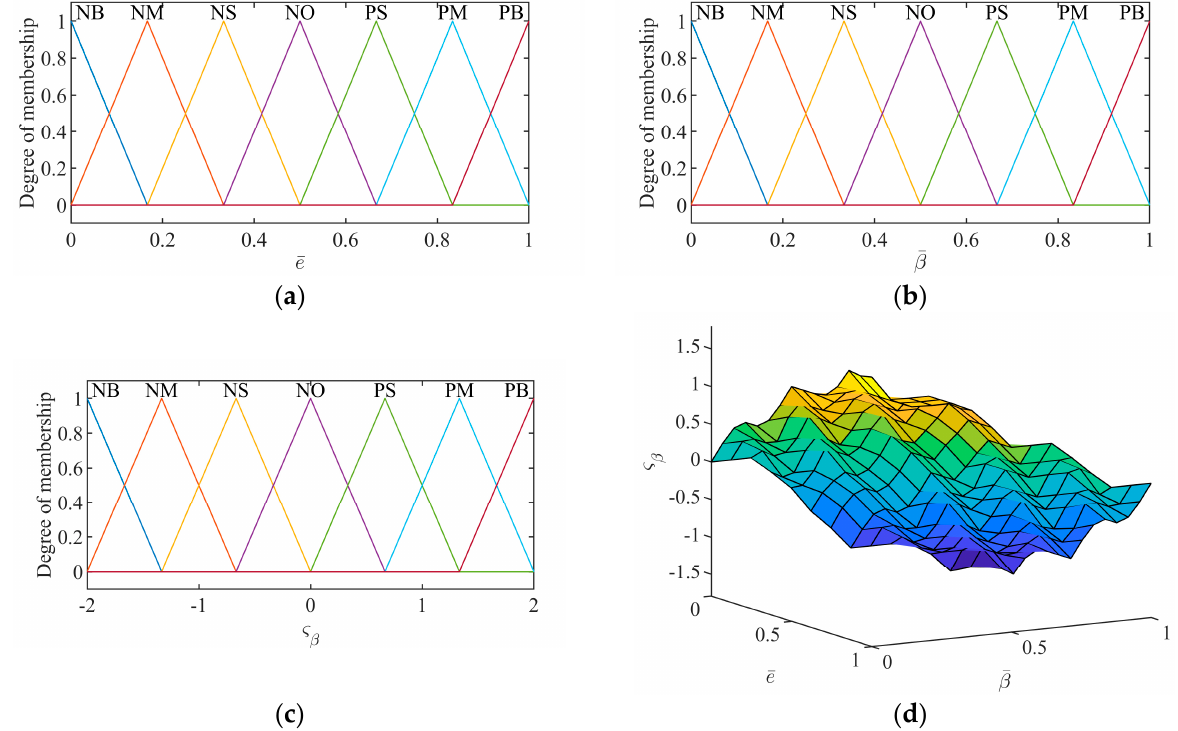
Figure 4. Fuzzy controller of Γ φ . ( a ) Membership function of e ; ( b ) Membership function of φ ; ( c ) Membership function of ς φ ; ( d ) Three-dimensional map.